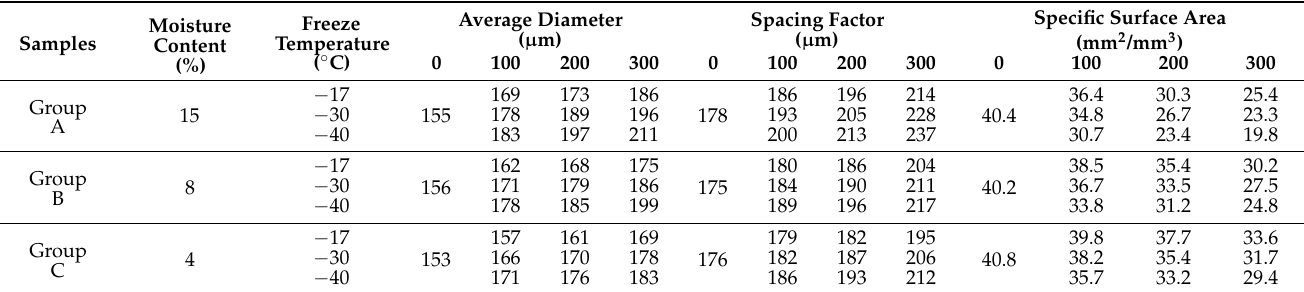
Table 3. Air void parameters test results.